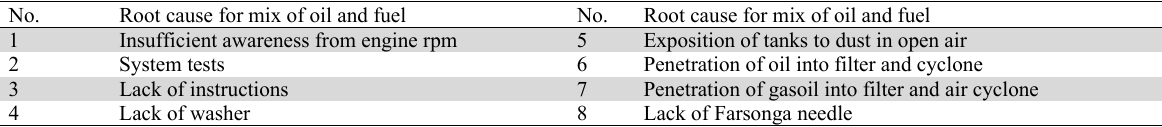
Root cause failure for mix of fuel and oil in UTD-20 engine No.